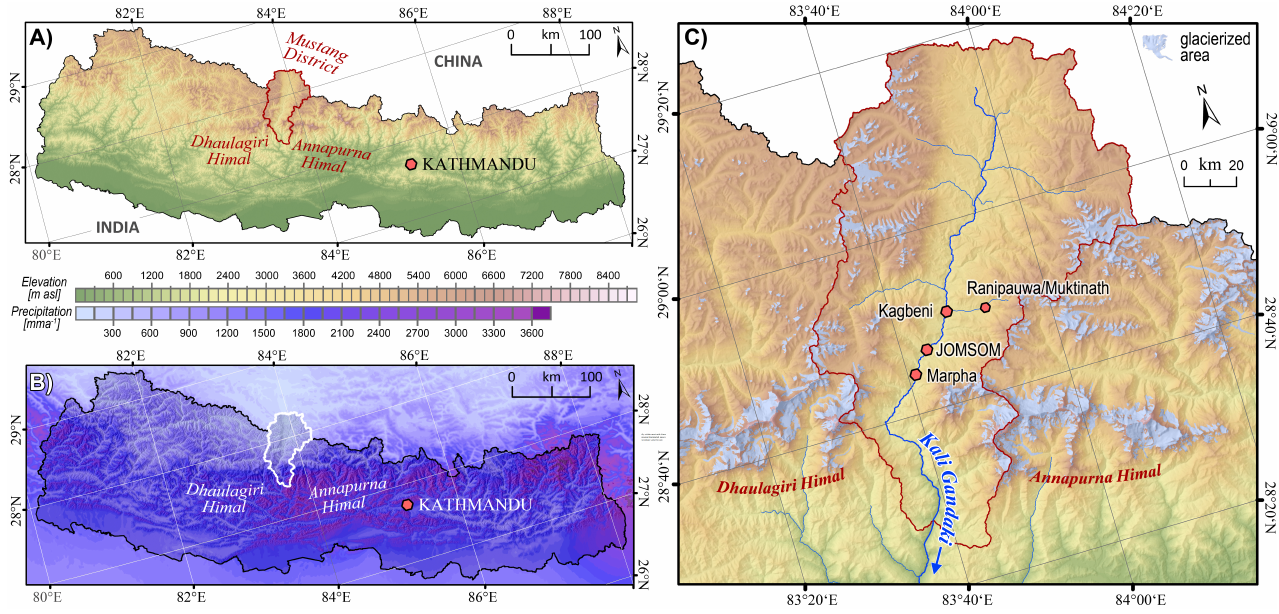
Figure 1. ( A ) Digital Elevation Model (m asl) of Nepal [61]. ( B ) Mean annual precipitation amounts (mma − 1 ) across the Himalayan Arc [45]. ( C ) Location of the investigated settlements Marpha, Jomsom, Kagbeni and Ranipauwa, close to the pilgrimage site Muktinath. Light blue shadings indicate glacier-covered regions at higher elevations